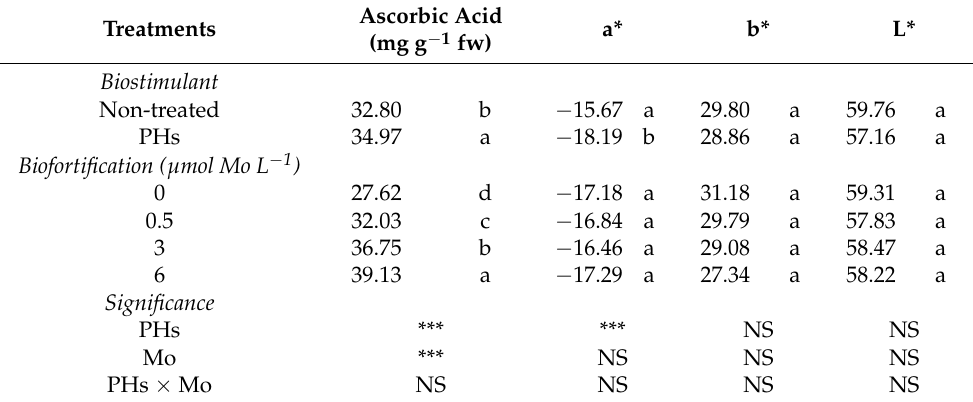
Table 3. Effect of PHs treatment and Mo-biofortification on ascorbic acid and CIELab parameters of ‘Canasta’ lettuce grown in a protected environment.